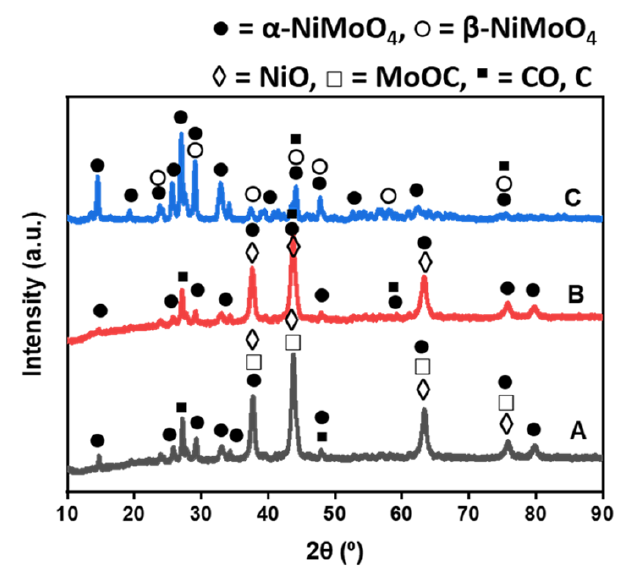
Figure 5. XRD pattern of prepared catalysts using different char activation methods: ( A ) NiMo/AC X , ( B ) NiMo/AC 0 and ( C ) NiMo/AC T